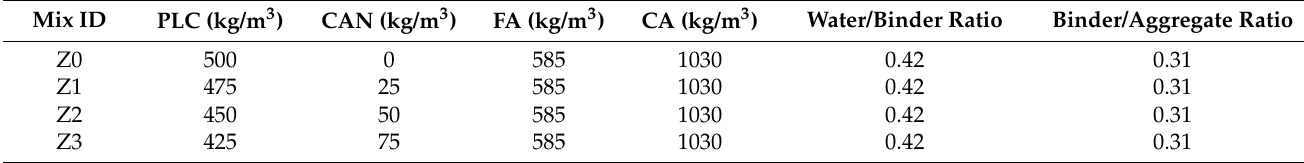
Table 4. Mix design proportions for M